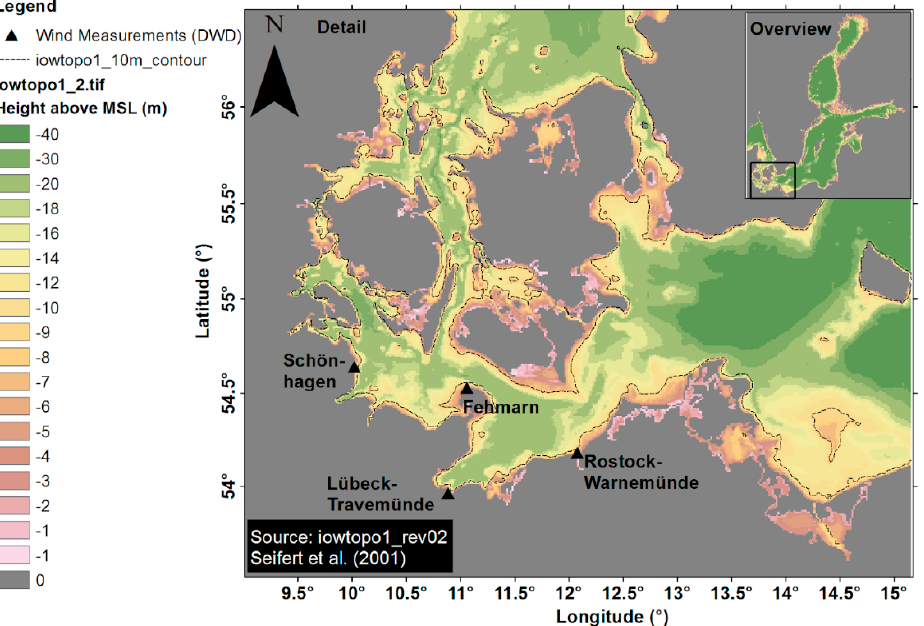
Figure 1. Selected locations with wind measurements of the Deutscher Wetterdienst (DWD, see black triangles) and bathymetry data of the SWAN wave model for the Western Baltic Sea area. Source of the bathymetry: [33].